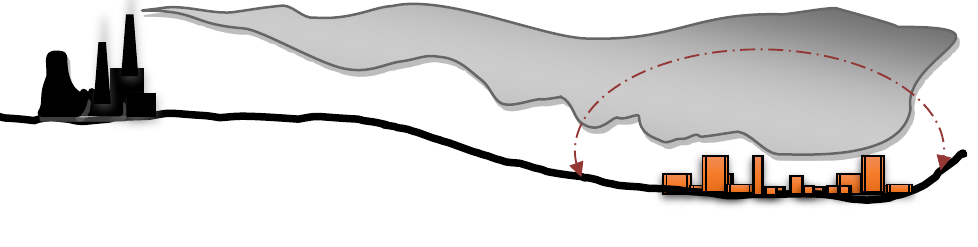
Fig. 3. City of Prishtina, land morphology and environmental climate hazard, according to the radius of emanation – Power plants Kosova A and Kosova B. Because of the contemporary life style and in commitment to have community necessary services, it is quite normal to have optimal services for ordinary functioning of the city activities, running power plants for electricity supply, and functioning traffic for everyday activities of city urbanites. However, the first thing is that we have to identify and maintain the priorities related to the public health concern. Besides of AQI contained index, “motor vehicles emit at least 40 different air pollutants, usually concentrated within busy roadways”